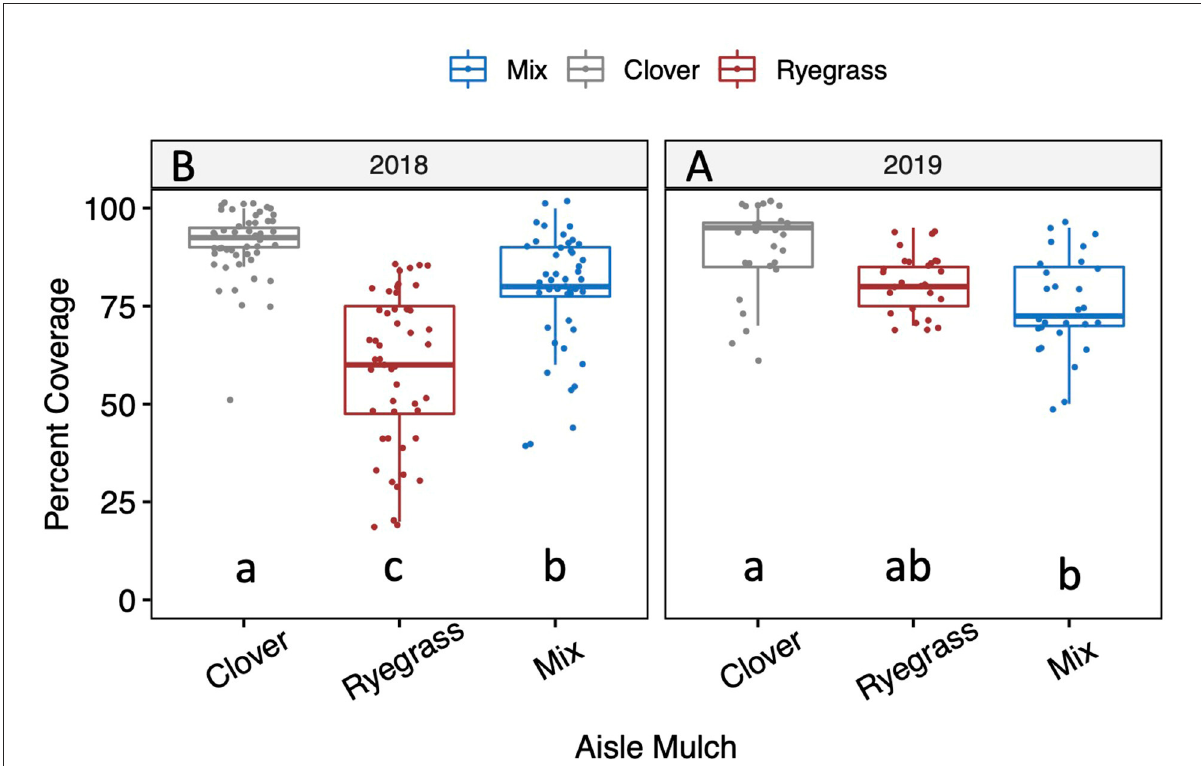
FIGURE5 Percent ground cover provided by living mulch treatments, 2018 and 2019. Lowercase letters indicate significance groupings for mulch treatments within a given year, while uppercase letters indicate significance groupings for year across mulch treatments. Treatments that share the same letter are not significantly different at p <